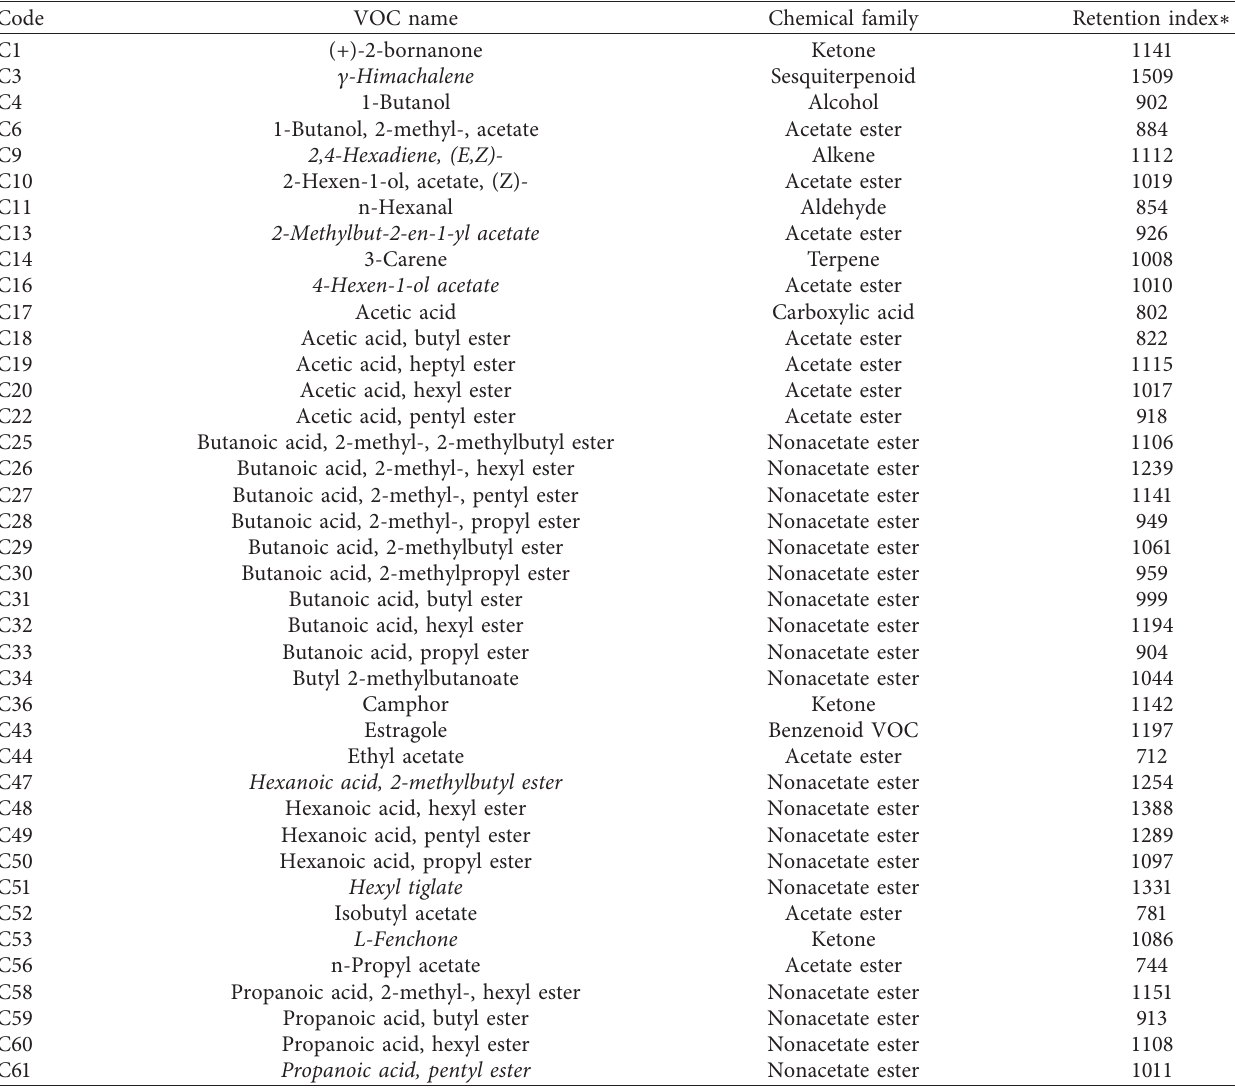
Table 1: List of VOCs detected across all samples and codes used for the statistical